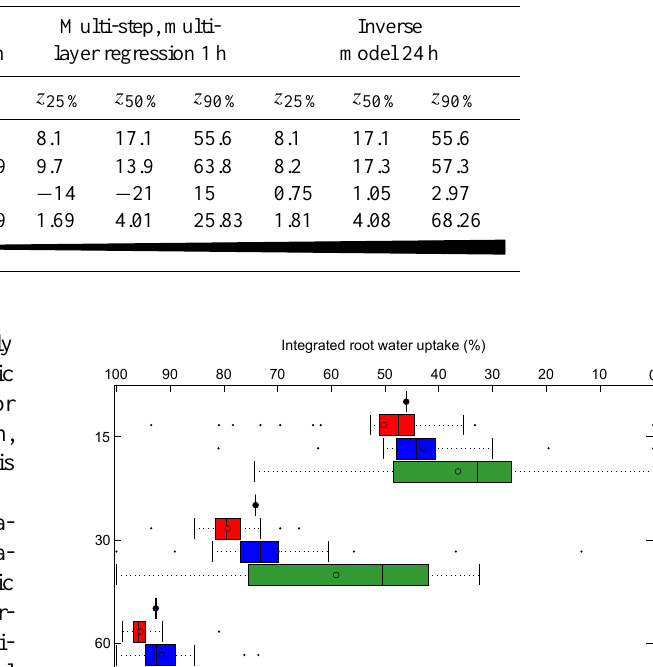
Table 3. Comparison of model performance for reproducing the sink term profile (single-step, multi-layer water balance; multi-step, multi- layer regression; and inverse model). Depths where 25, 50 and 90 % water extraction occurs were regarded. Mean synthetic (syn.) depth and mean estimated (est.) depth describe the mean depth over 33 days where water extraction occurs. b is the relative bias and e s is the standard deviation of the estimated values. Larger width of the black arrow denotes higher accuracy of the model results.